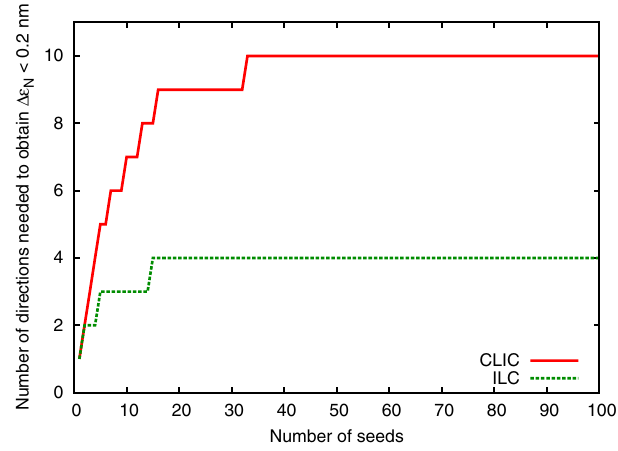
FIG. 11. The minimum number of principal seed directions required to reduce emittance growth to less than 0.2 nm quickly converges, both for CLIC and ILC. Even for a large number of seeds, four directions are sufficient for ILC. For CLIC the corresponding number is ten.